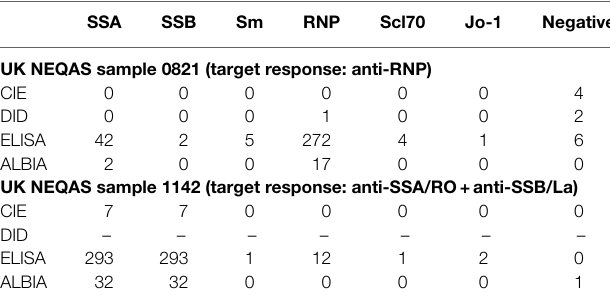
TABLE 1 | Number of specific anti-ENA responses in two UK NEQAS samples sorted according to the laboratory techniques employed .